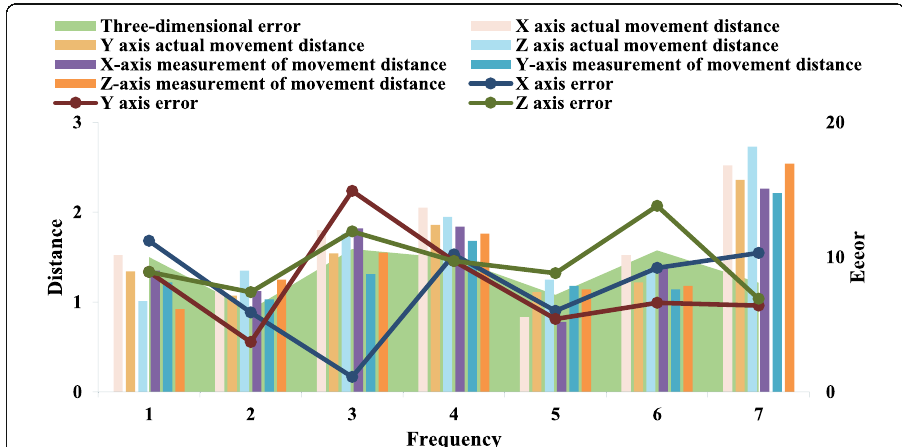
Fig. 5 System three-dimensional space tracking experiment